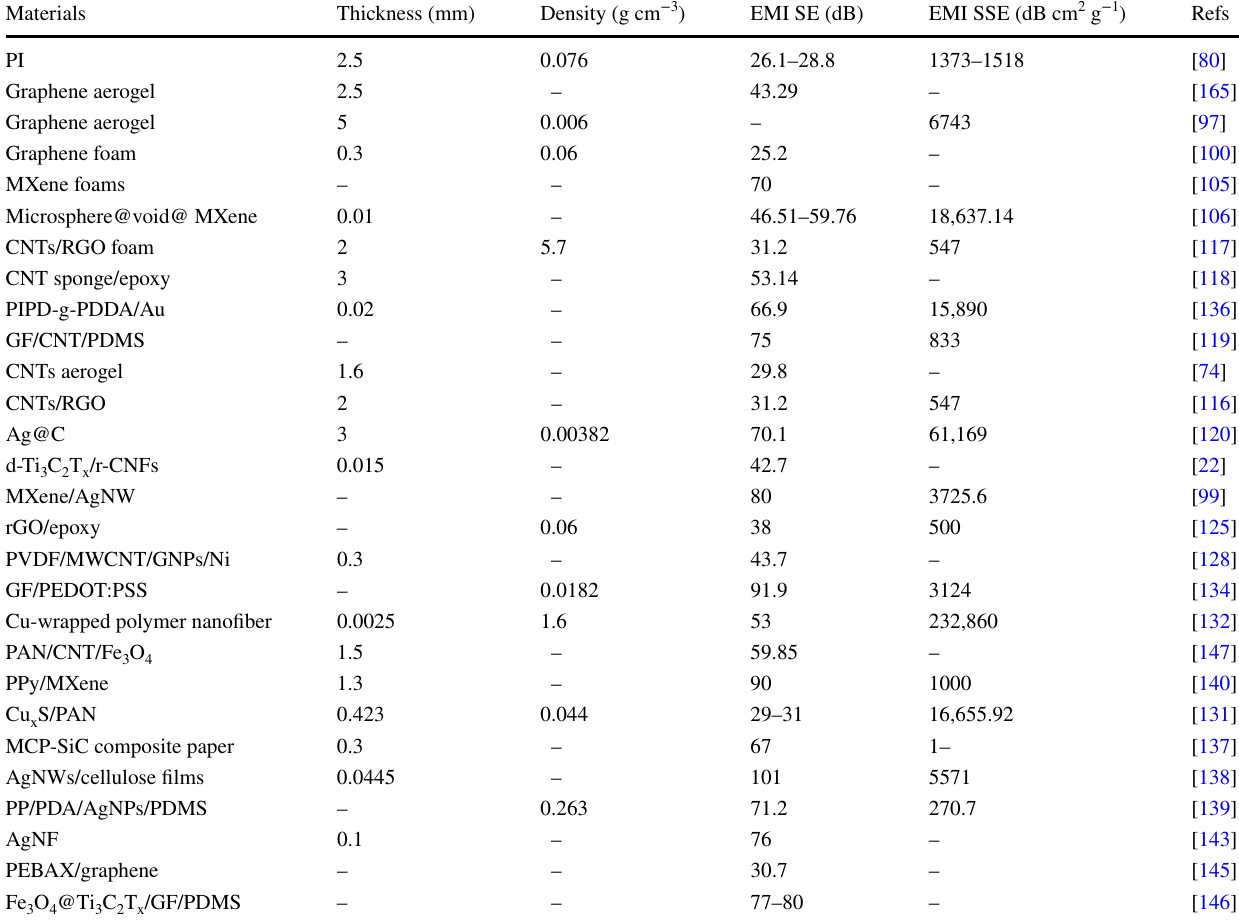
Table 1 Comparison of EMI SE of representative flexible EMI shielding materials